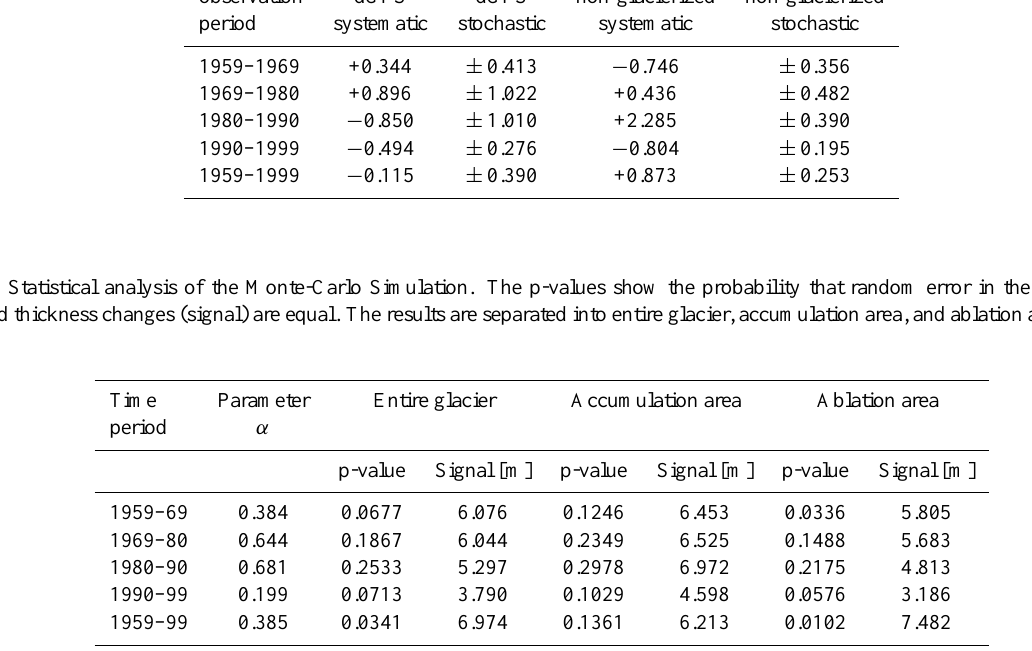
( a) , as well as the probabilities for accumulation, ablation, and total glacier area of all time periods. The coefficient a shows that the dependence of the error on slope is